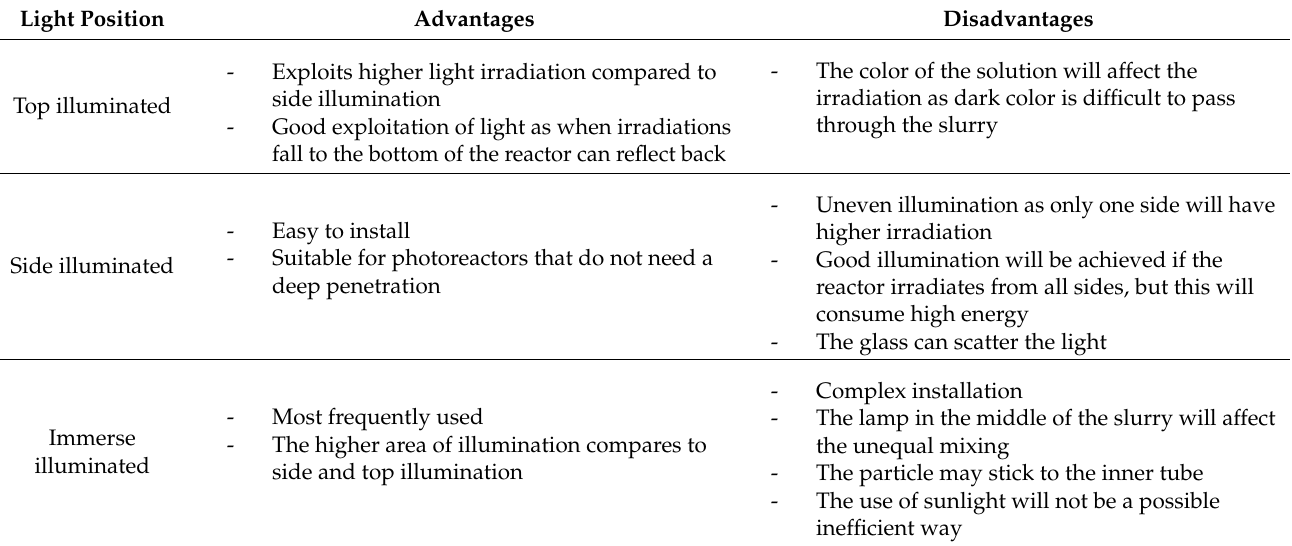
Table 4. Advantages and disadvantages of various types of photoreactor illumination [118]. Repro- duced with permission from Khan and Tahir. Copyright © 2022